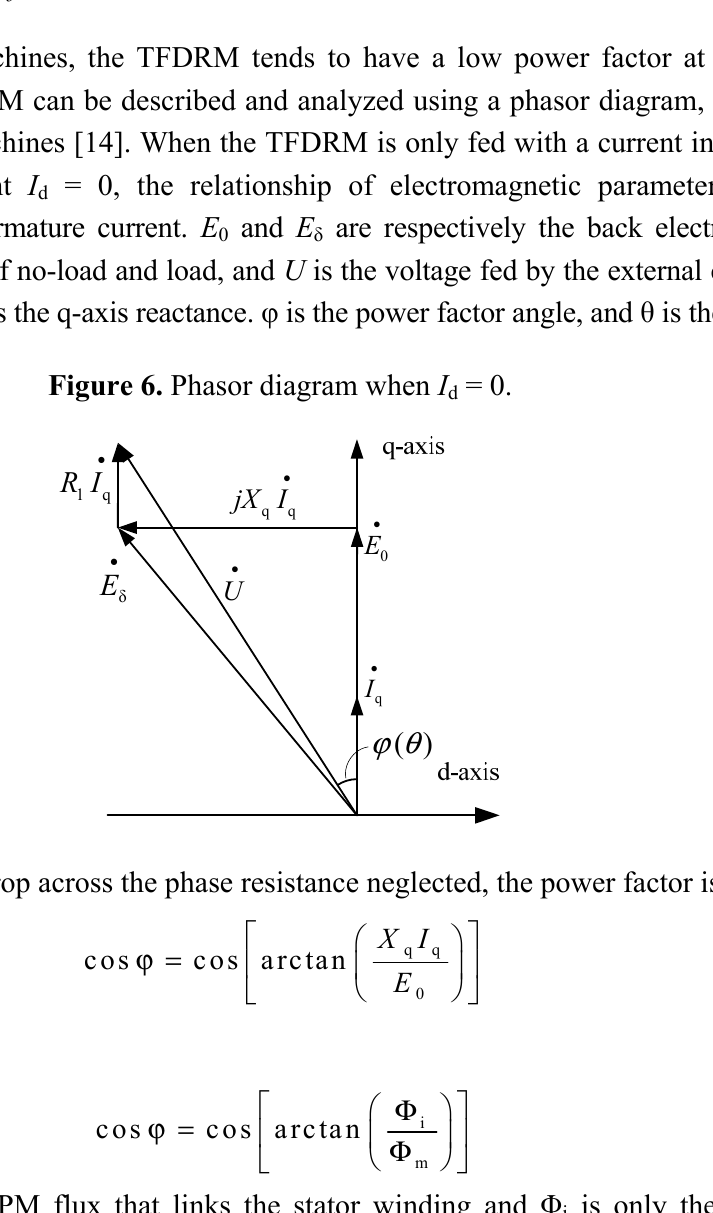
Figure 6. Phasor diagram when I